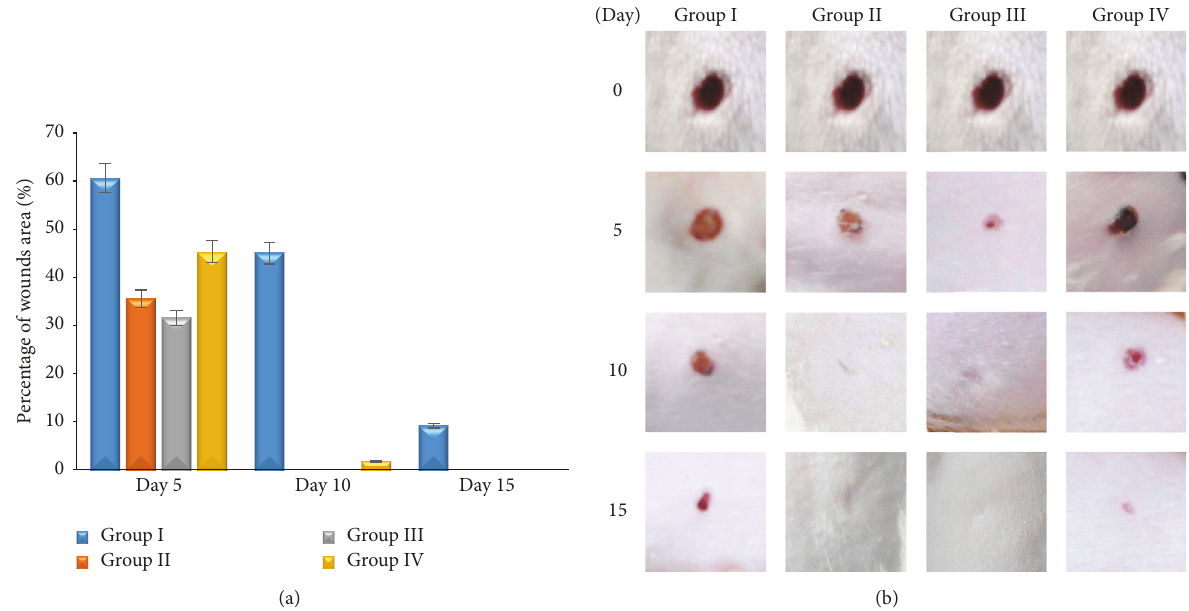
Figure 1: Percentage of wounds area (a); macroscopical examination of wound area from each group